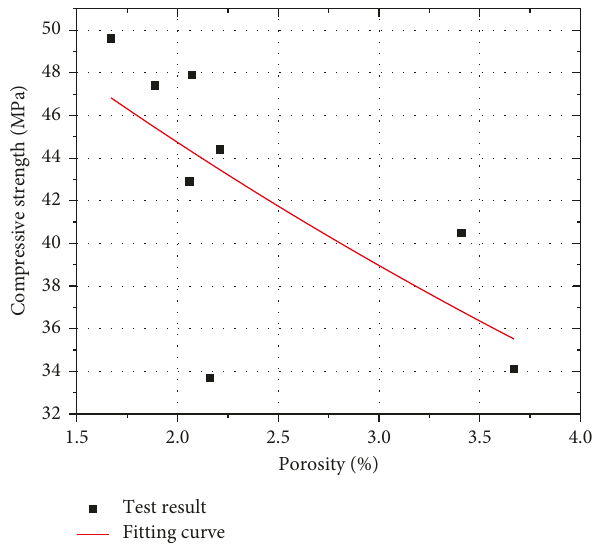
Figure 18: Relationship between porosity and uniaxial compressive